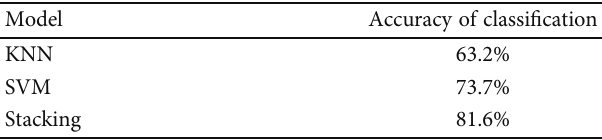
Table 5: Default model prediction results.